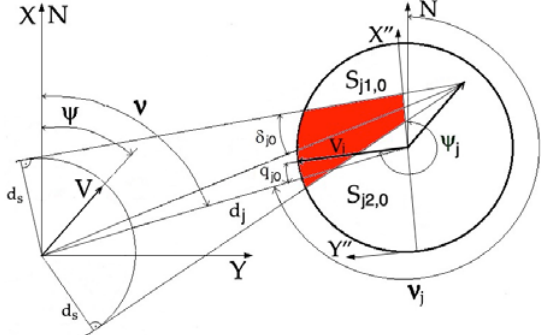
Figure 4. Sets of permissible strategies S j1,0 and S j2,0 for the encountered ship j, in order to maintain a safe passing distance d s from the considered ship.